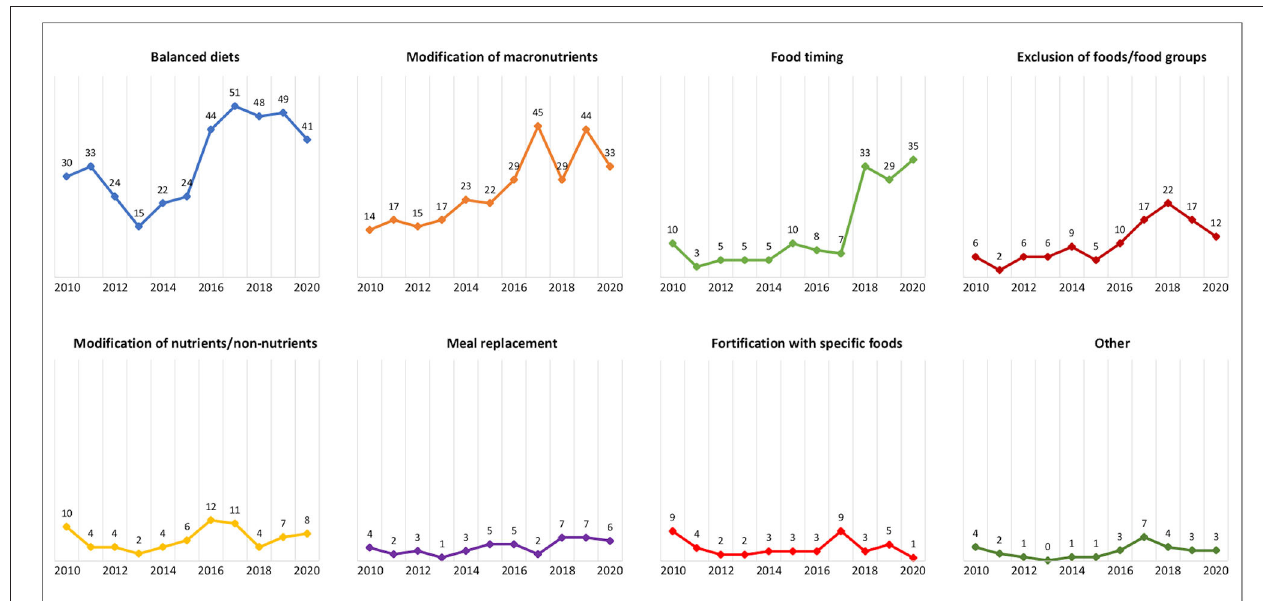
FIGURE 4 | Number of registered trials over time according to dietary